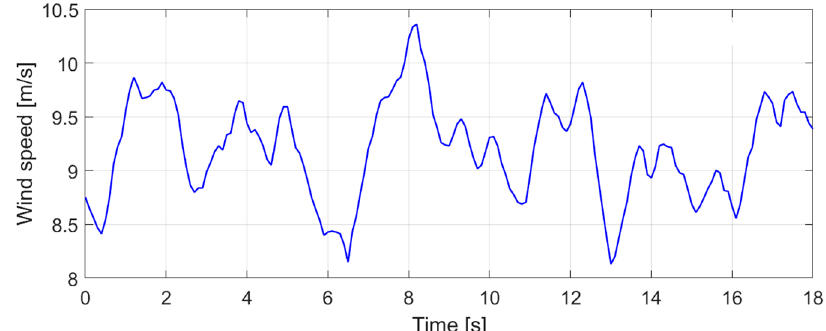
Figure 8. The variable wind speed profile applied in Case studies 1, 2 and 3.